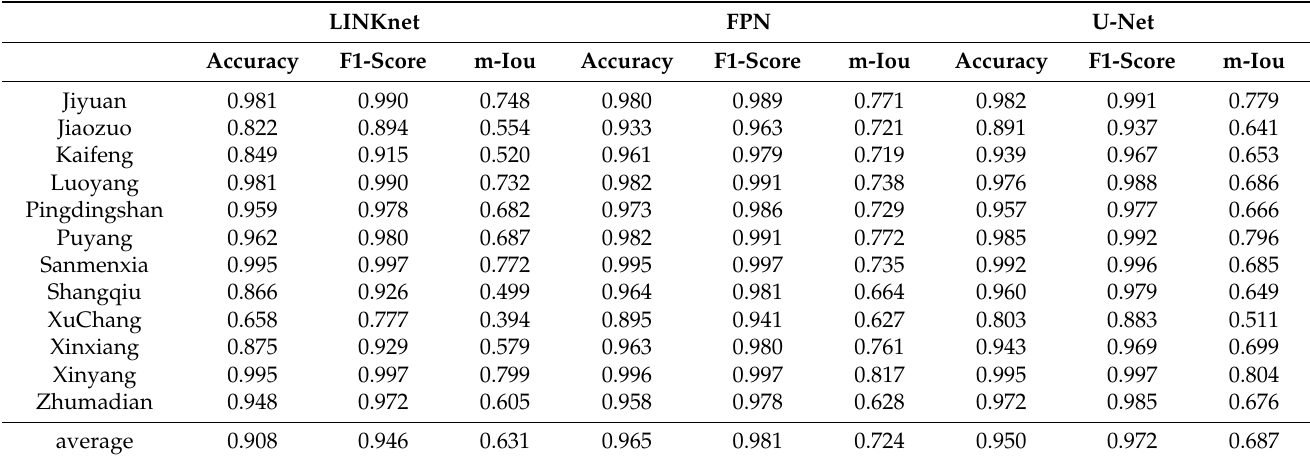
Table 4. Test results of the urban boundary sample database for Henan Province.